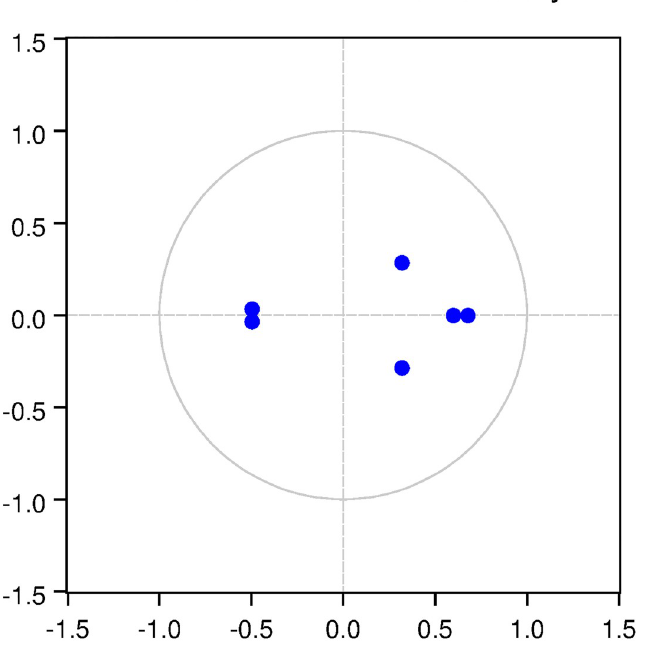
Fig 8. Inverse roots of AR characteristic polynomial for Swiss data when P = 2 (proposed model).